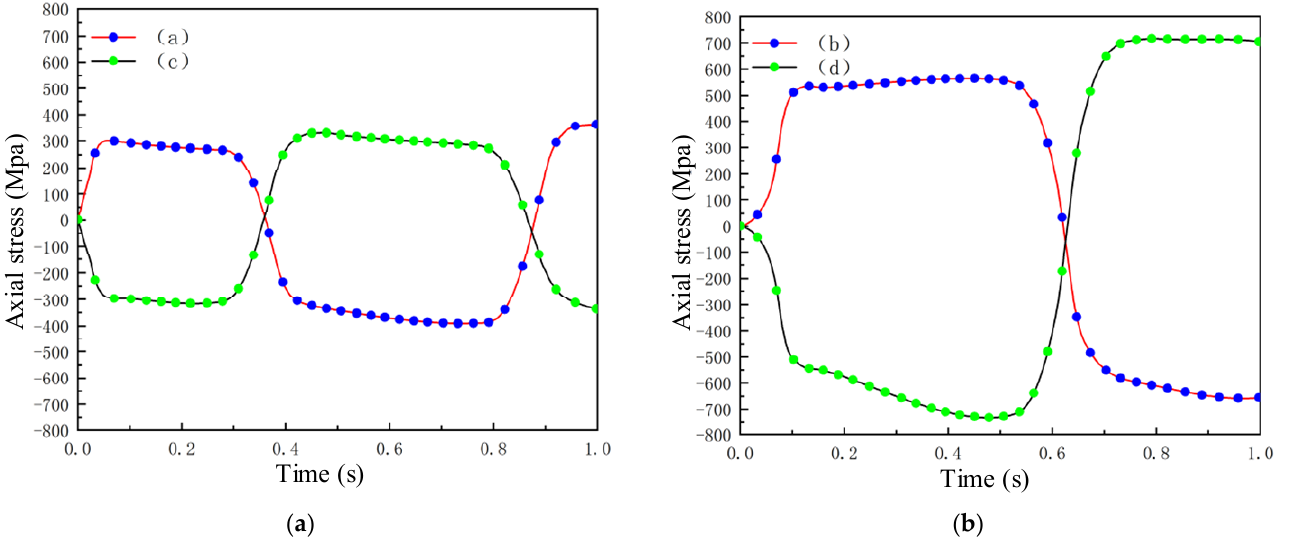
Figure 11. Variation of axial stress at four positions of V-groove section under eccentric wheel loading: ( a ) Variation of axial stress at point a and point c; ( b ) Variation of axial stress at point b and point d.